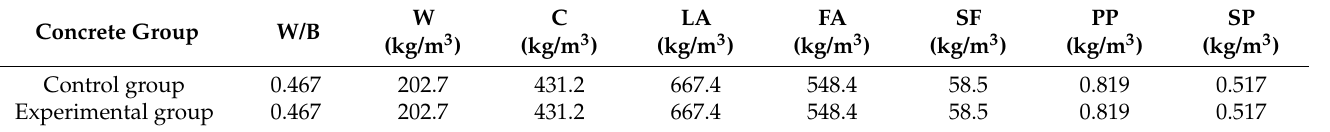
Table 2. Mix proportions of the concretes.